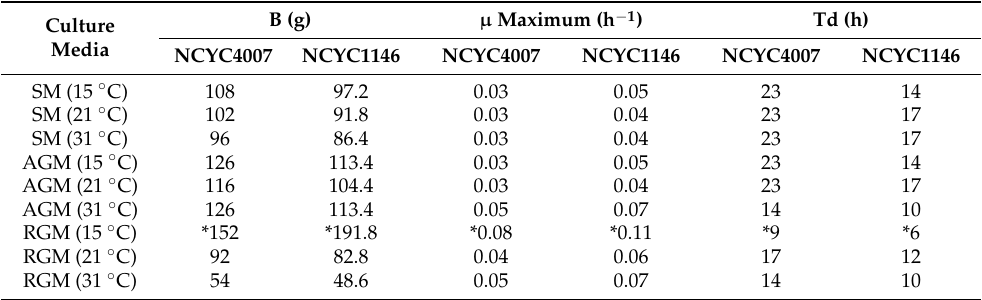
Table 1. Kinetic growth parameters of the NCYC 4007 and NCYC 1146 strains obtained by the tested culture media at three different temperatures (15, 21 and 31 °C). Total biomass production in dry weight (B), maximum growth speed ( μ maximum) and duplication time (Td).